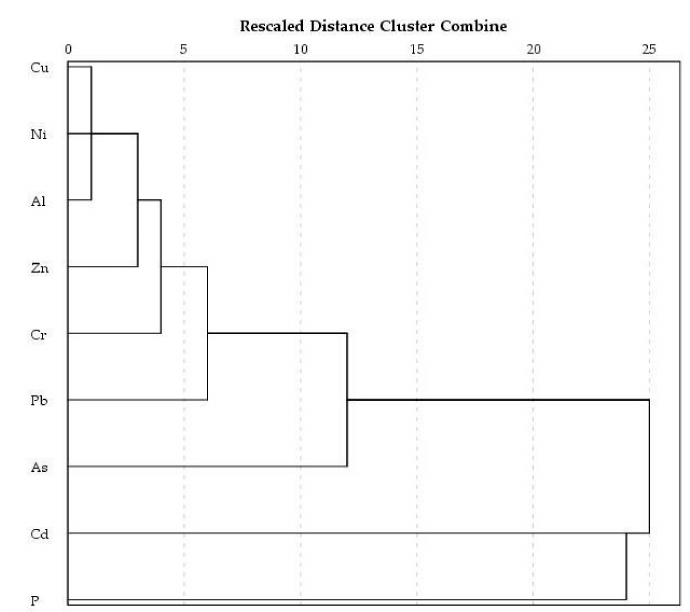
Figure 5. Dendrogram showing clustering of the targeted nine potentially toxic elements.